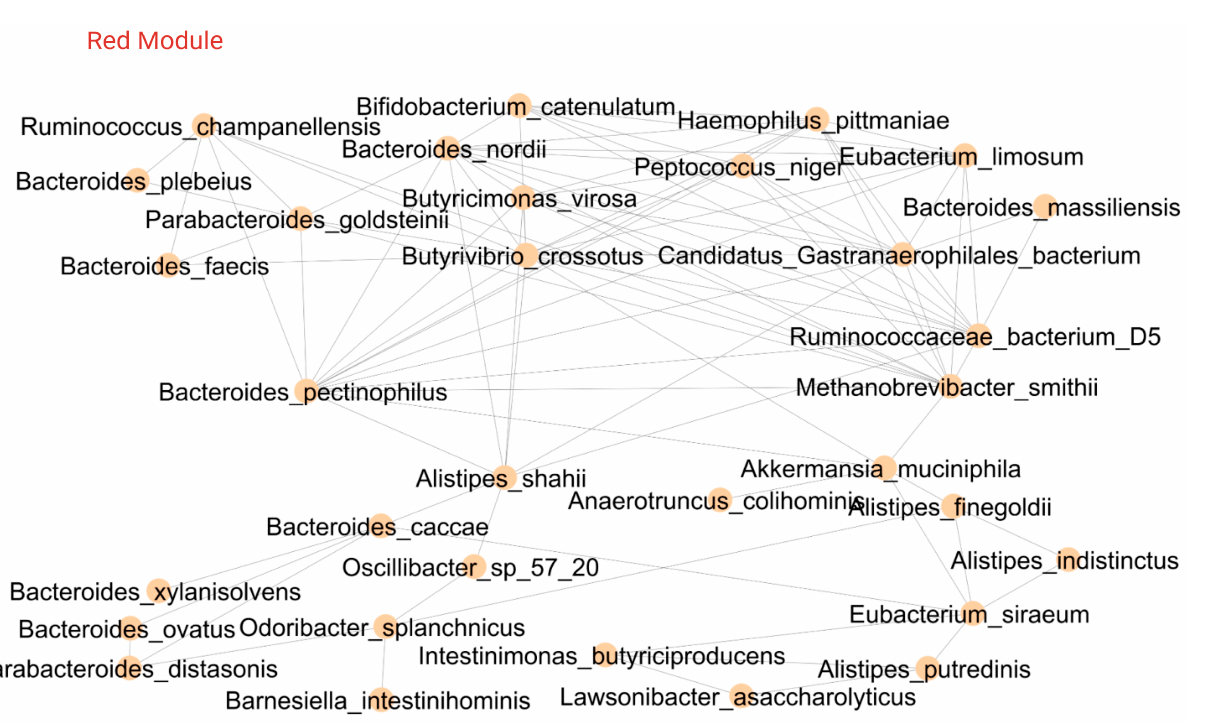
Figure 6. Low-risk CAG module (red module) with health-associated